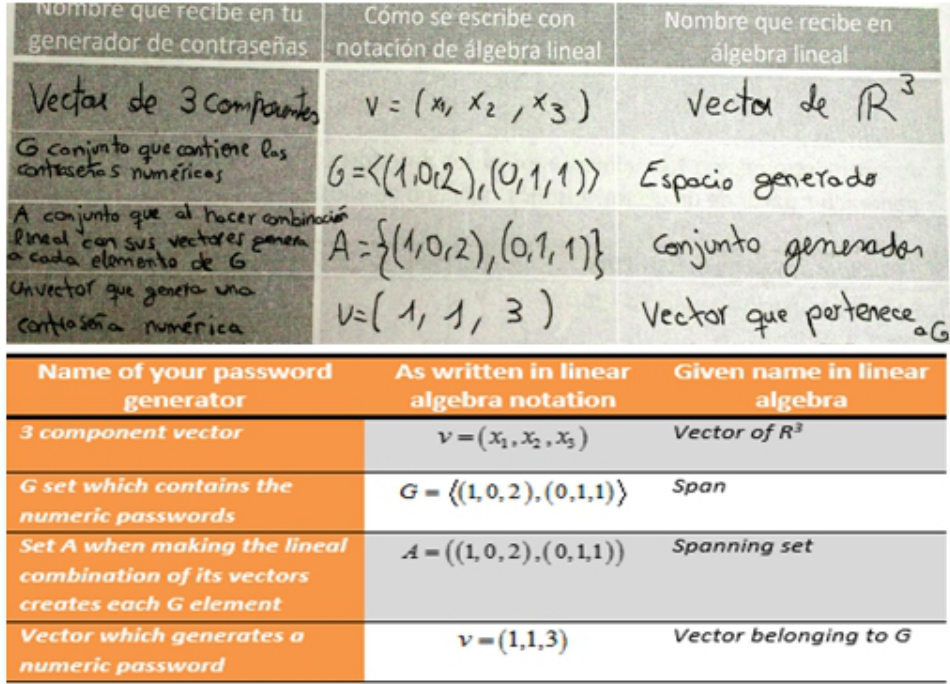
Figure 4. Example of an answer of part II of task 2